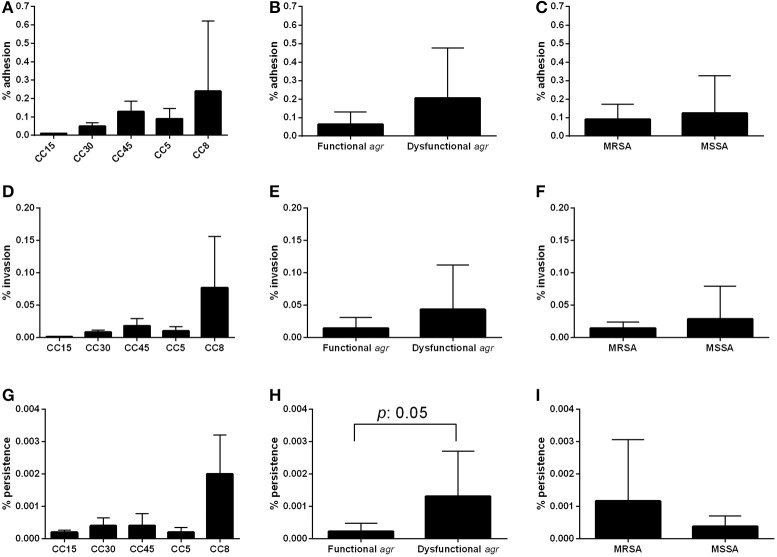
Adhesion, invasion, and intracellular endothelial cells assay. Confluent endothelial cell obtained from umbilical cord veins were infected with 107 CFU and the percentage of bacterial cells able to adhere (A–C), invade (D–F) and persist intracellularly (G–I) is represented according CC, agr functionality and methicillin resistance. Results are expressed as the percentage of the initial inoculum recovered. Bars and error bars indicate the mean and standard deviations of at least three independent experiments. Only significant p-values are shown.